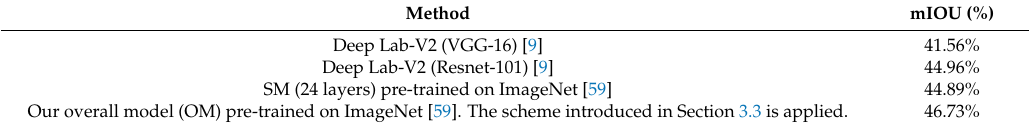
Table 2. Mean pixel IOU (mIOU) of human parsing on Look into Person (LIP)